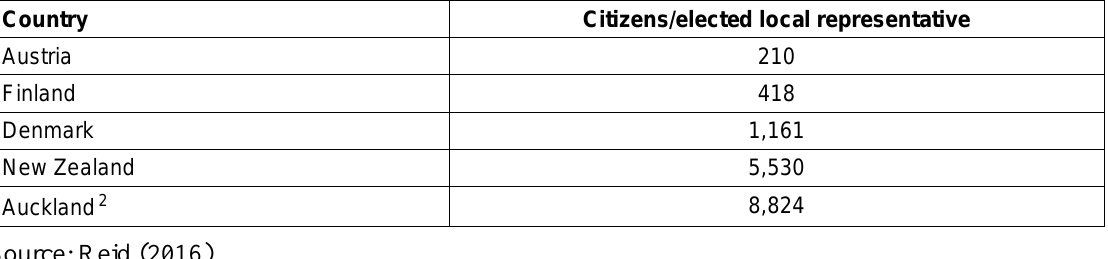
Table 1: Citizens per local elected representative – international